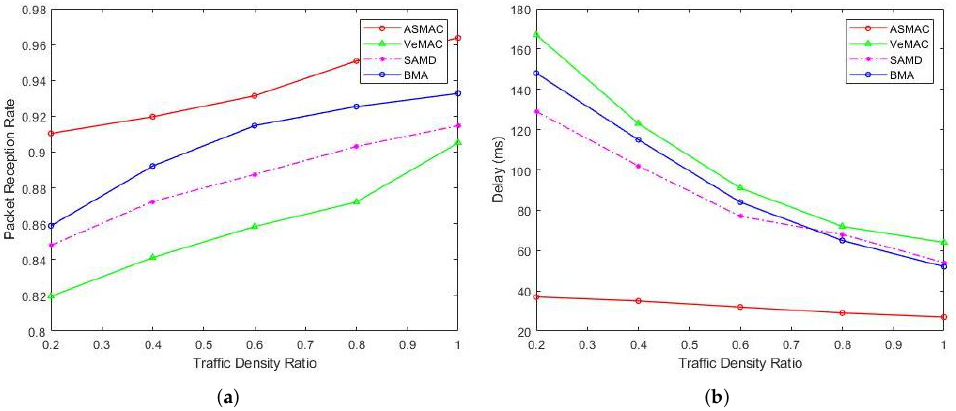
Figure 9. ( a ) Packet reception rate and ( b ) delay under different traffic density ratios when the number of vehicles is